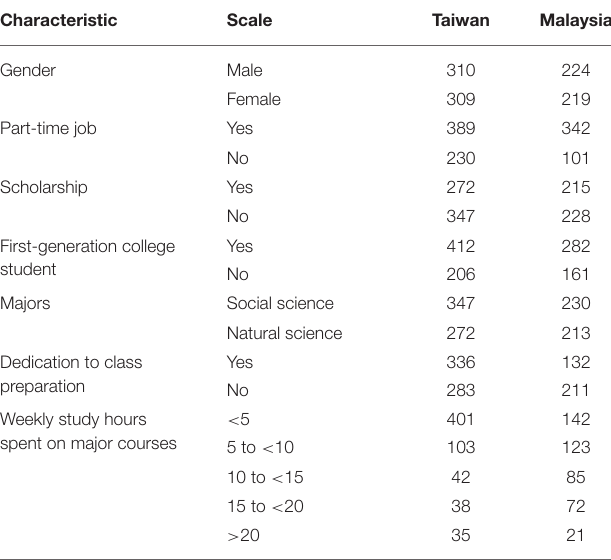
TABLE 1 | Descriptive statistics of Taiwanese and Malaysia